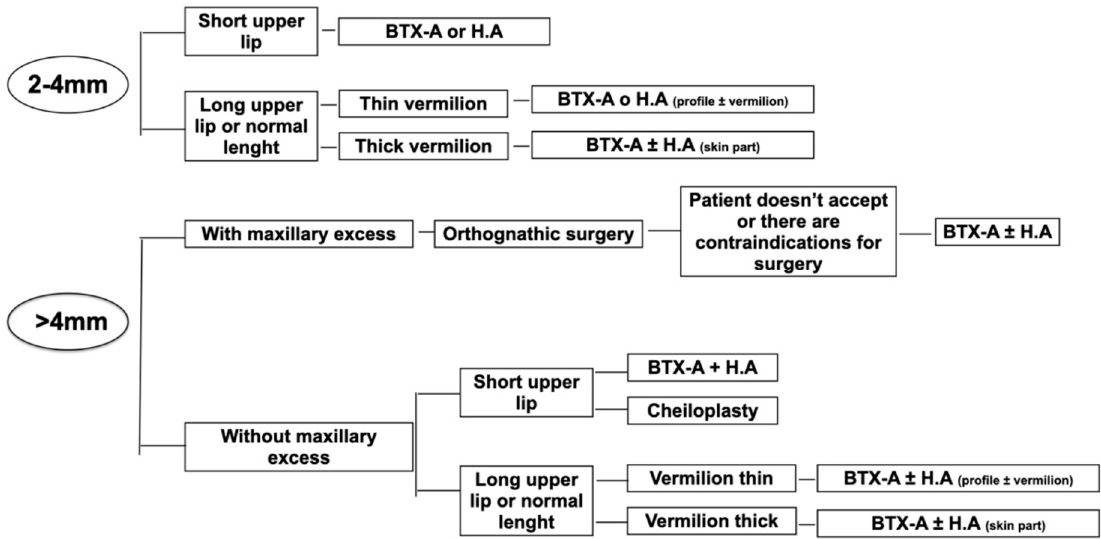
Figure 9. Proposal treatment algorithm according to anterior gingival exposure. BTX-A decreases muscle strength in hyperactivity of certain muscles. The most common injection site corresponds to the anatomical confluence between the levator